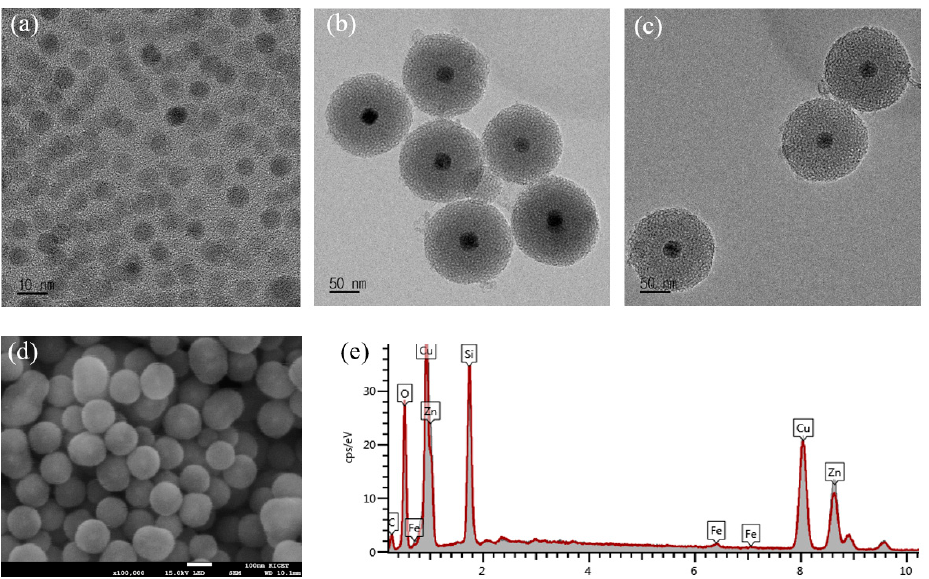
Figure 1. TEM images for morphologic structure analysis of synthesized nanoparticles. ( a ) OA-capped SPION, ( b ) mSiO 2 @SPION, ( c ) mSiO 2 @SPION after modifying with β -diketone Eu 3+ complex ( d ) SEM image of mSiO 2 @SPION and ( e ) EDX analysis results of mSiO 2